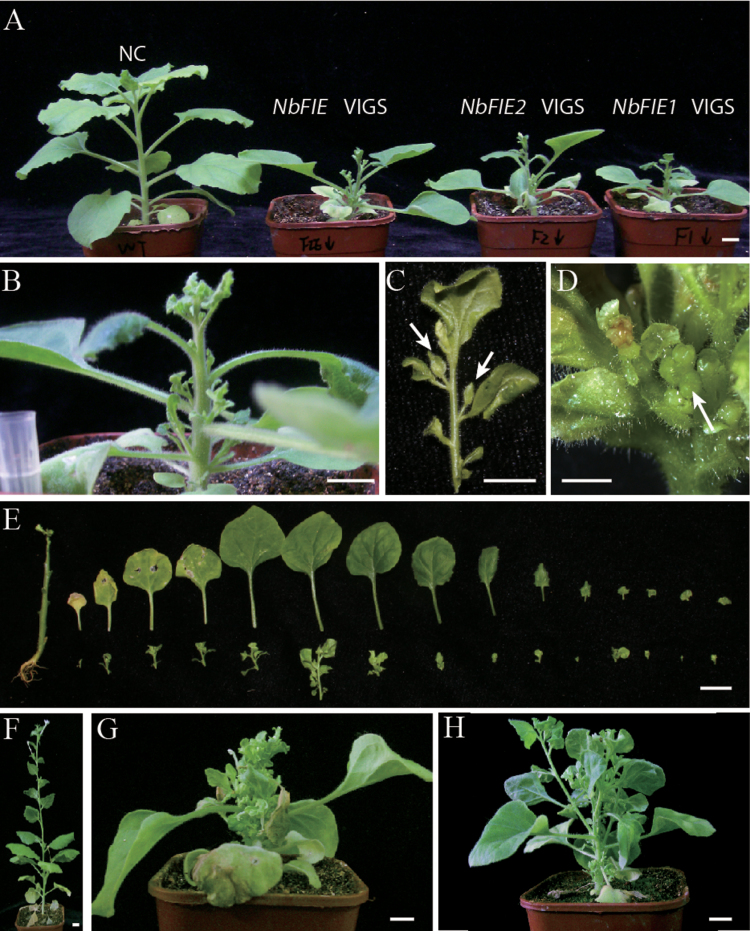
VIGS experiments to silence both NbFIE1 and NbFIE2 genes. (A) Plants at 24 DAI from VIGS experiments using the common fragment of NbFIE1 and NbFIE2 (NbFIE VIGS) as well as the full-length cDNA of the NbFIE1 gene (NbFIE1 VIGS) or the NbFIE2 gene (NbFIE2 VIGS). NC, control plants. (B) A side view of an NbFIE-silenced plant at 24 DAI. (C) A typical first-order lateral branch from an NbFIE-silenced plant at 24 DAI. The arrows showed the extended second lateral branches. (D) A magnified view of the inflorescence meristem on an NbFIE-silenced plant at 24 DAI. The arrow indicates that the inflorescence meristem arrested with several tiny organs. (E) A dissected NbFIE-silenced plant at 24 DAI. Each of first-order axillary buds and lateral branches (the lower line) paralleled the corresponding nodal leaves (the upper line). (F) A negative control plant at 56 DAI. (G, H) NbFIE-silenced plants at 56 DAI with strong and mild phenotypes. Bars in (A–C) and (E–H), 1cm; bar in (D), 0.5cm.